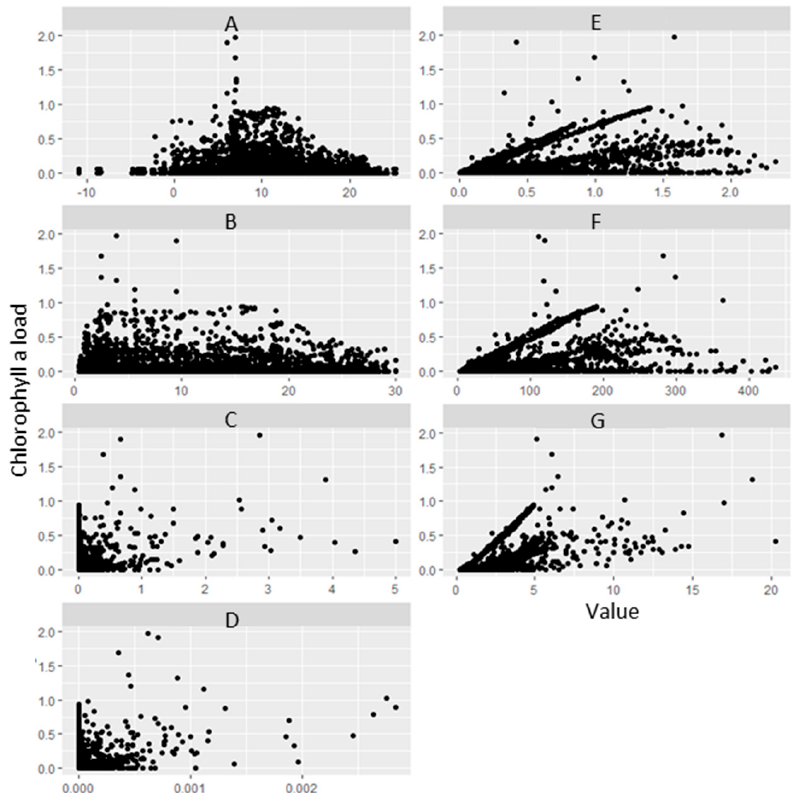
Figure 2. Chlorophyll a simulation results in relation to the selected parameters: Water temperature ( A ), solar radiation ( B ), surface runoff ( C ), chlorophyll a land delivery from the sub-basin area ( D ), flow ( E ), total nitrogen load ( F ), and total phosphorus load ( G ).